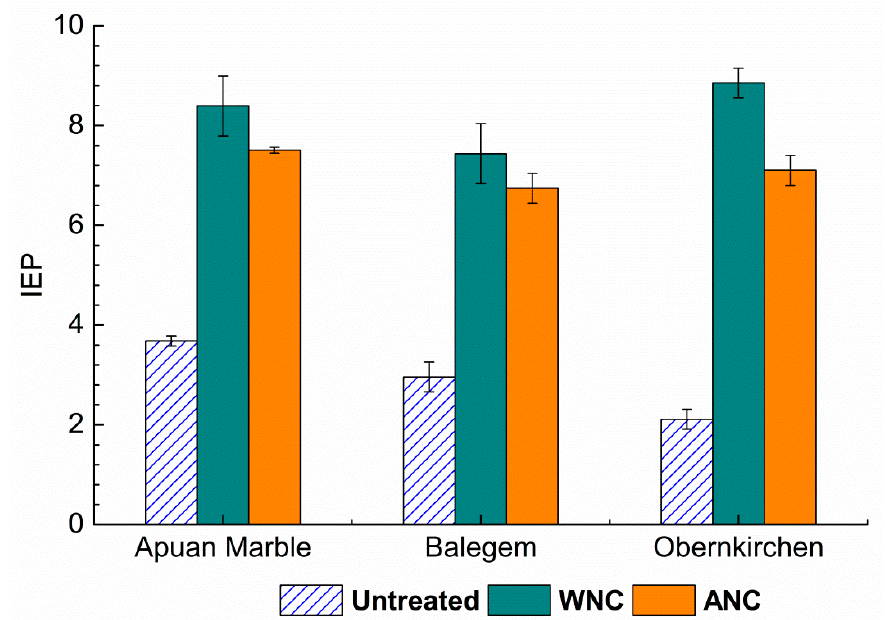
Figure 3. Isoelectric points (IEP, in pH units) of the three lithotypes before and after treatment with WNC/ANC. Values for untreated lithotypes were obtained by averaging the two sets of values reported in Table 6.